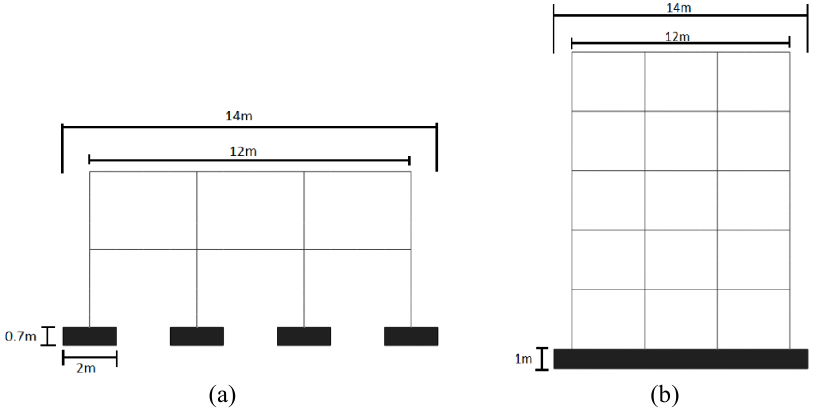
Fig. 2. Schematic view of building foundation: (a) building with 2 floors and (b) building with 5